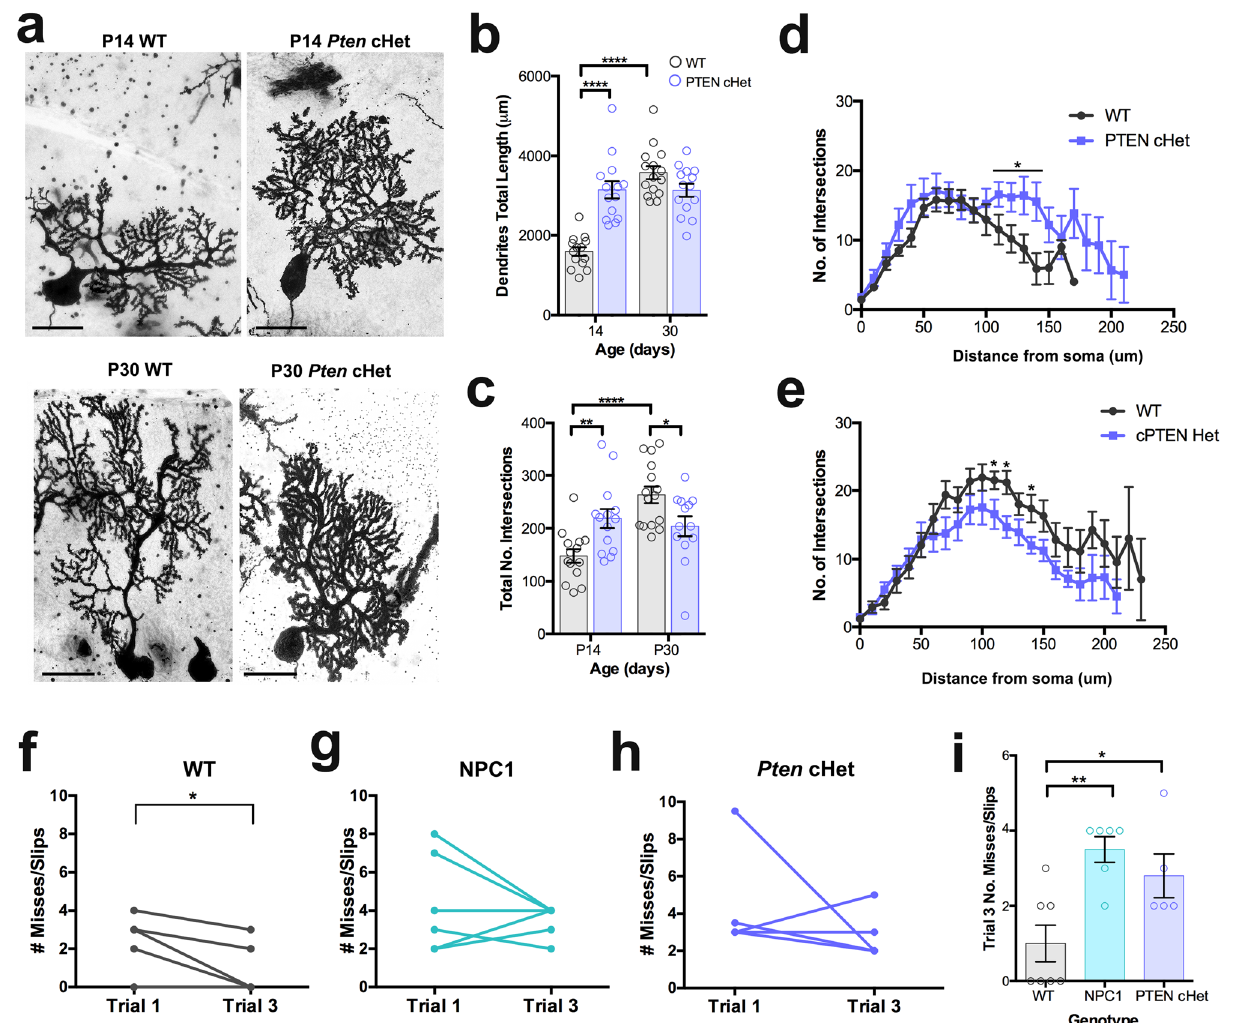
Figure 6. Pten conditional haploinsufficiency in PCs alters the postnatal development of their dendrites at P14. ( a ) Golgi-Cox staining of PCs from WT and Pten- cHet mice at P14 and P30. ( b ) Quantification of PC dendritic total length at P14 and P30 showing significant differences between WT and Pten- cHet mice at P14, no changes were found at P30. ( c ) Quantification of dendritic total intersections calculated by Sholl analysis at P14 and P30 showing significant differences between WT and Pten- cHet mice. Data in ( a ) and ( b ) are presented as mean ± SEM, n = 4 mice/genotype/age, 4–5 cells/mouse. ( d ) Sholl-analysis showing differences in PC dendritic branching between WT and Pten- cHet mice at P14. ( e ) Sholl-analysis showing differences in PC dendritic branching between WT and Pten- cHet mice at P30. Data are presented as mean ± SEM, n = 4 mice/genotype/ age, 4–5 cells/mouse. ***P < 0.001, ****P < 0.0001. ( f ) The number of mises/slips in the ladder rung task were significantly decreased between trials 1 and 3 in P30 WT mice (n = 7). ( g , h ) No significant differences in number of mises/slips in the ladder rung task were found between trials 1 and 3 in P30 Npc1 nmf164 ( g , n = 6) and Pten- cHet ( h , n = 5) mice. ( i ) The total number of misses/slips in trial 3 was significantly higher in Npc1 nmf164 (n = 6) and Pten- cHet (n = 5) mice when compared to WT mice (n = 7). Data are presented as mean ± SEM, n = 2 images from 4 mice/genotype/age. *P < 0.05, **P < 0.001. Scale bar: ( a ) 20